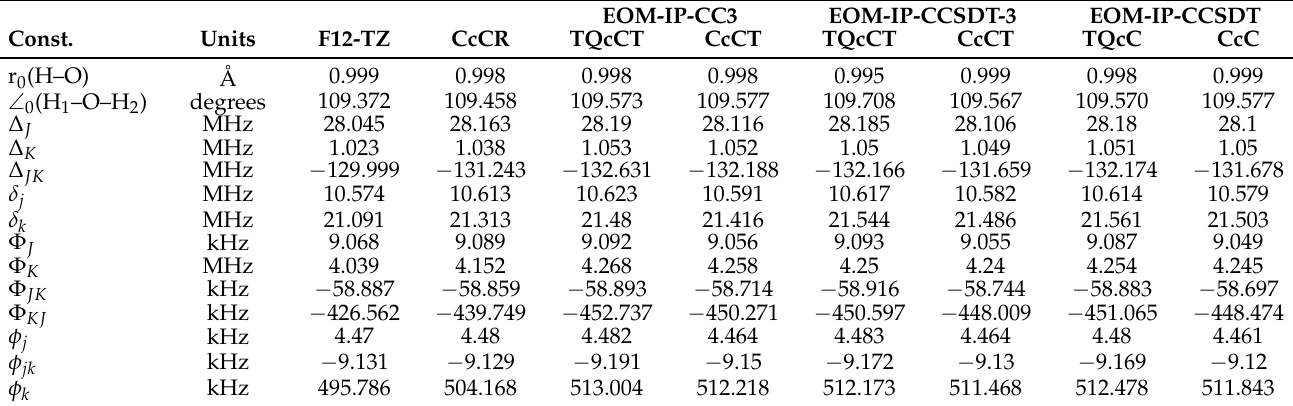
Table A1. ˜X 2 B 1 H 2 O + Geometrical Parameters and Quartic & Sextic Distortion